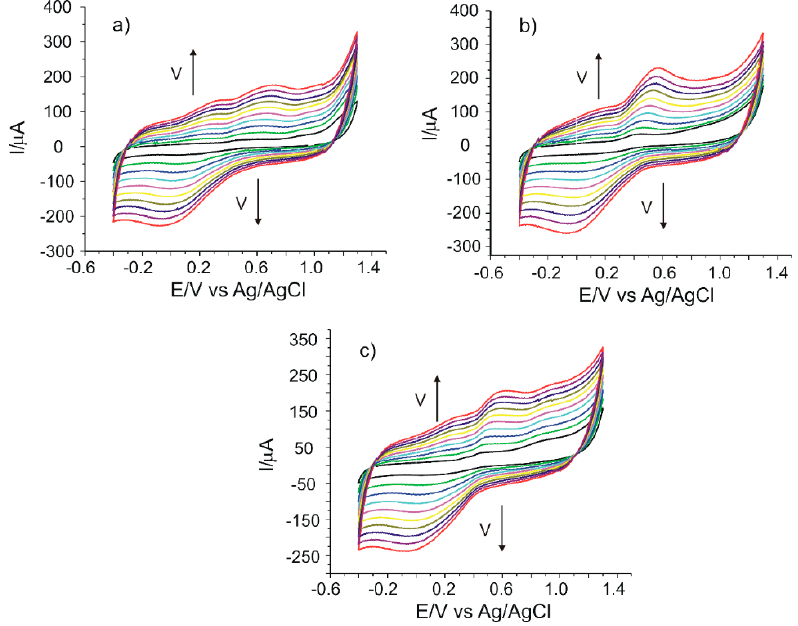
Figure 6. Cyclic voltammograms of CNF/C-SPE immersed in solutions of ( a ) Active Detox, ( b ) DVR- Figure6. CyclicvoltammogramsofCNF / C-SPEimmersedinsolutionsof( a )ActiveDetox, ( b )DVR-Stem Stem Glycemo and ( c ) green tea, recorded at scan rates between 0.1 and 1.0 V·s − 1. Glycemo and ( c ) green tea, recorded at scan rates between 0.1 and 1.0 V · s − 1.